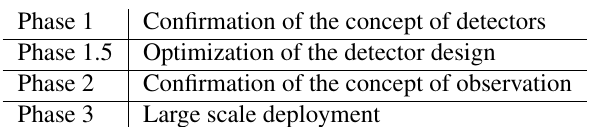
Table 1. Roadmap of the CRAFFT project